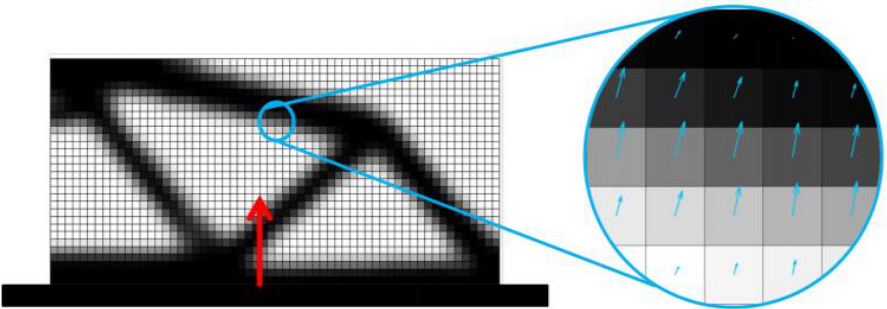
Figure 3. The detail shows part of the density field with the approximated gradients of the density field. The gradient vectors point in the direction of increasing density [22].